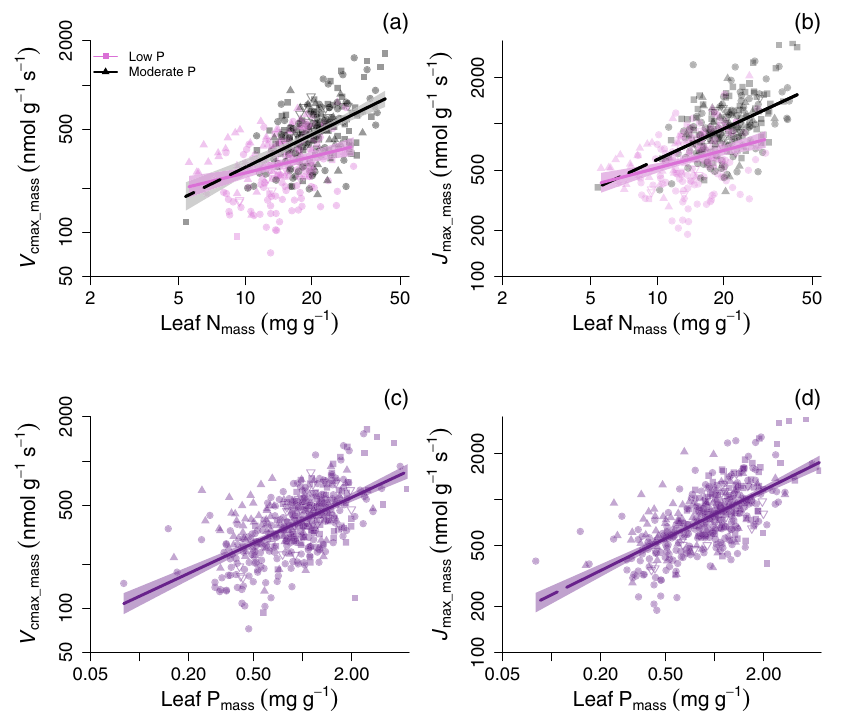
Fig. 1 | Relationships between leaf photosynthetic characteristics and leaf N and P for diverse woody species across continents. a , b Relationships between mass-based photosynthetic parameters and leaf N concentration (N mass ) for tro- picalandsubtropicaltreesacrossfourcontinents,forspeciesgroupedintotwoleaf P (P mass )classes, “ low P ” ( P <0.92mgg − 1 ) and “ moderateP ” ( P ≥ 0.92mgg − 1 ).Low P dataandlinesin a , b areplum-coloured,withmoderatePspeciesshownasgreyand black.Lines areleast-squares fi tsand the shaded areasarethe 95%CIregions. Each point represents the mean of a species-site combination, where different symbols